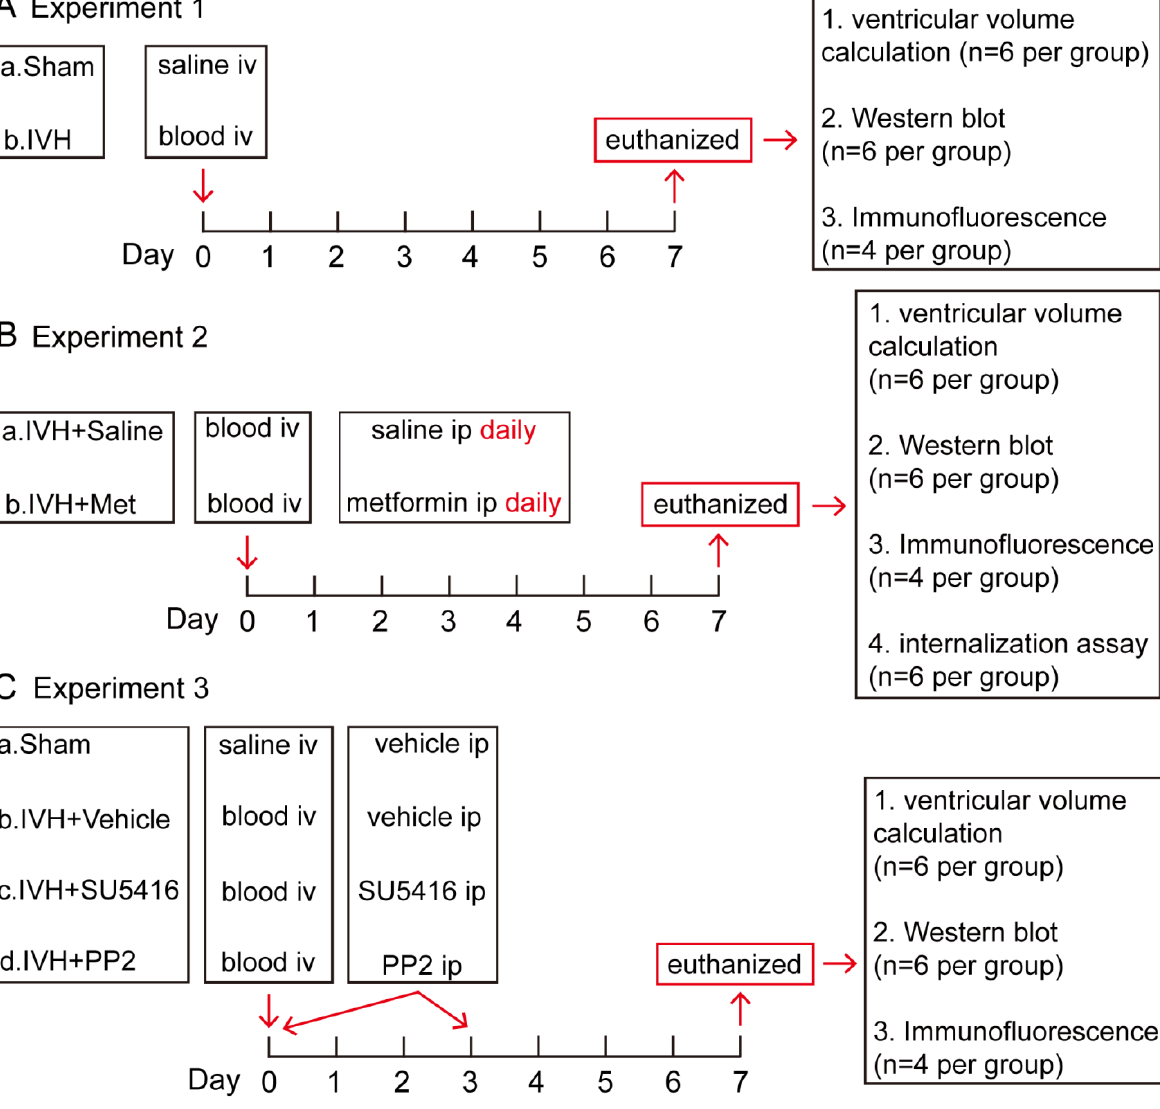
Figure 6. Experimental designs. ( A ) Experiment 1 was designed to investigate ventricular dilation and the VE–cadherin expression after IVH. ( B ) Experiment 2 was designed to explore the mechanism of metformin’s protection in IVH-induced hydrocephalus. ( C ) Experiment 3 was designed to explore the mechanism of VEGF/VEGFR2/p-Src pathway in hydrocephalus.